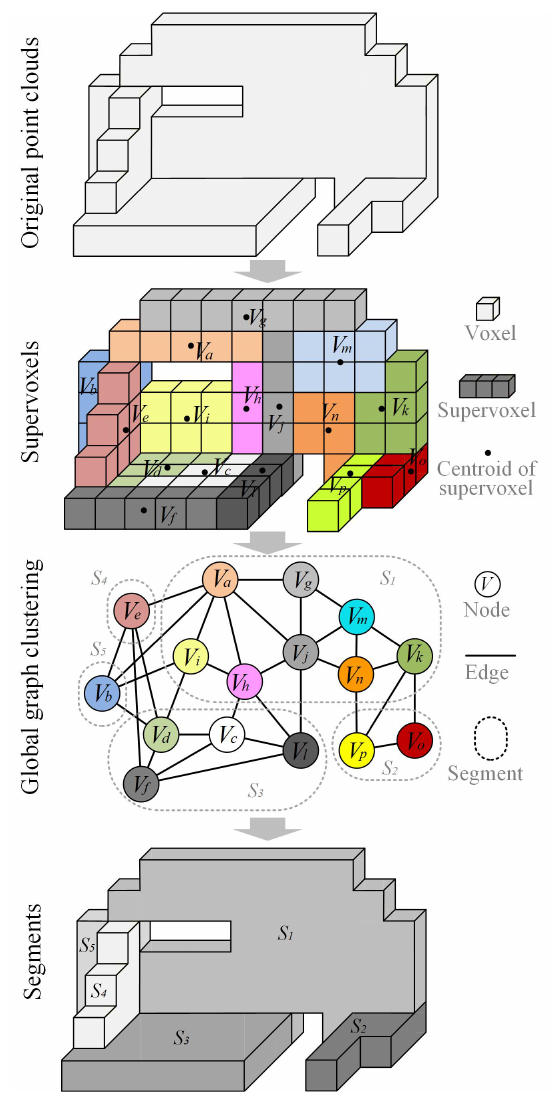
Figure 2. global graph-based